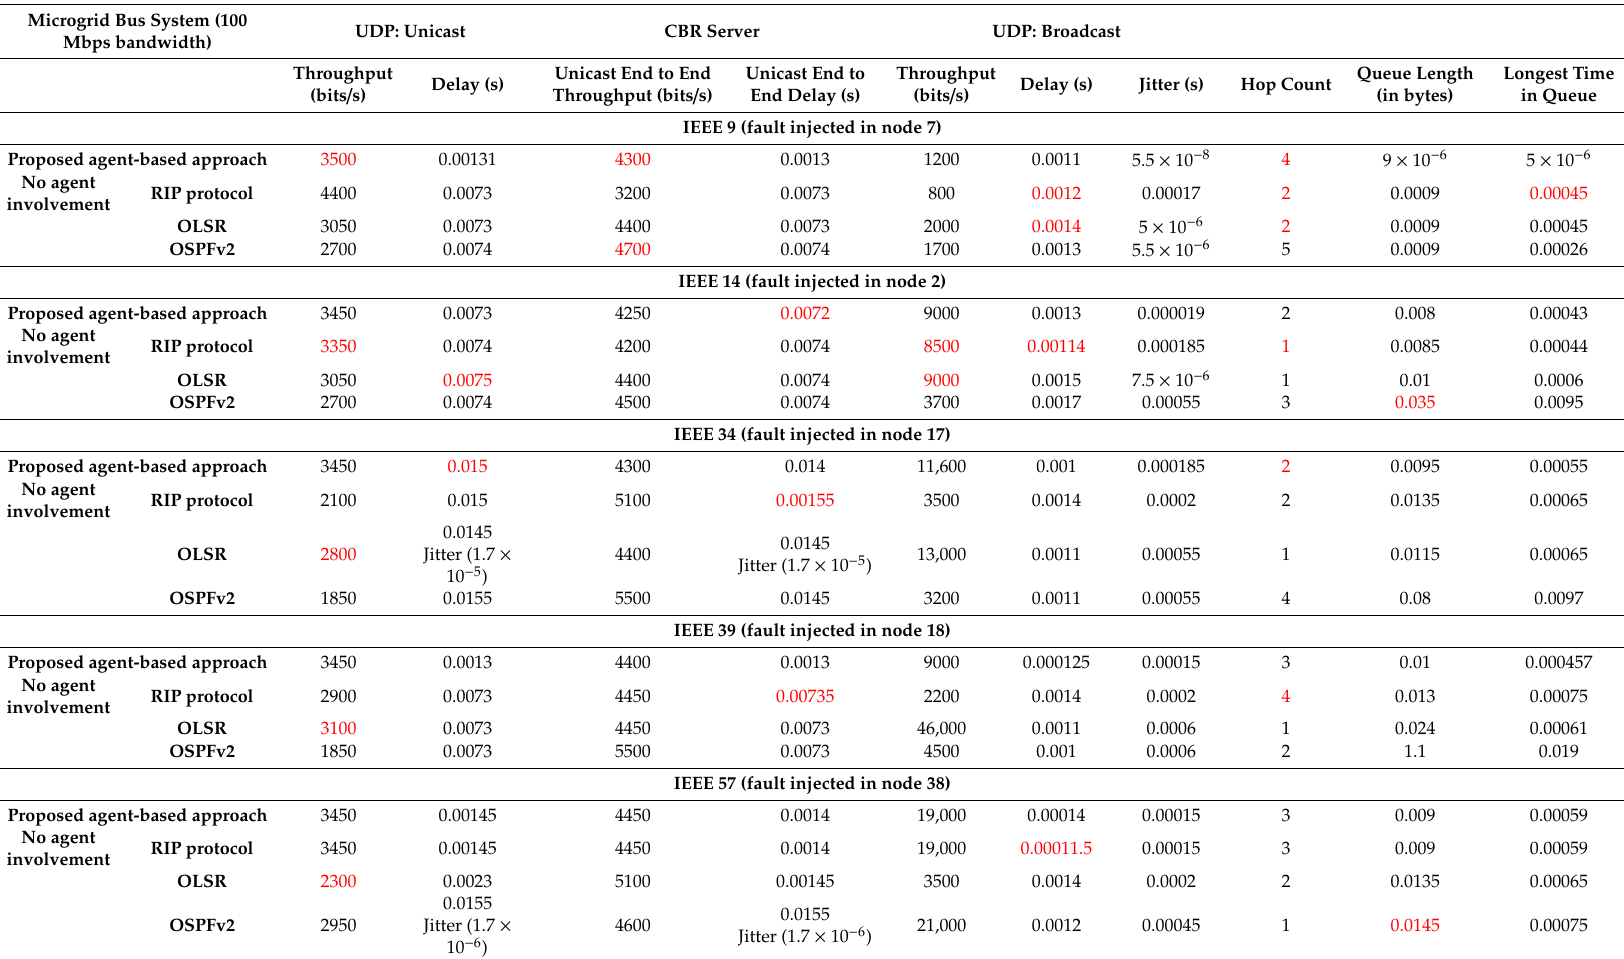
Table 3. Performance evaluation of the bus system for fault case study 1 in the microgrid communication